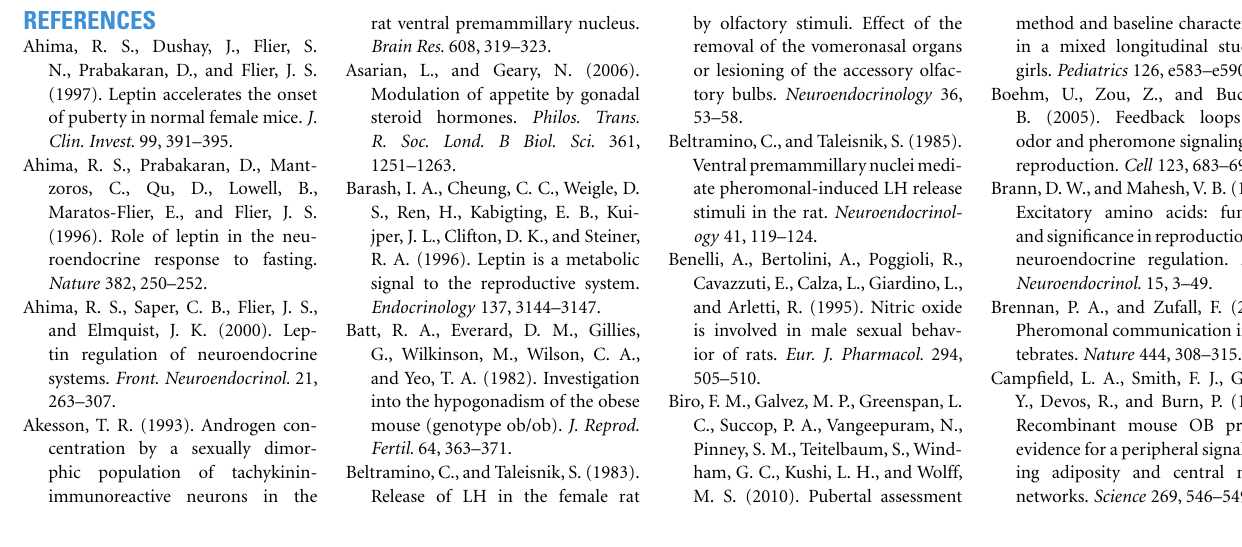
FIGURE 2 | Proposed role for the ventral premammillary nucleus (PMV) in the female reproductive physiology. The PMV integrates environmental cues (odors in rodents and daylight in seasonal breeders) and signals from the internal milieu related to the reproductive status (sex steroids) and energy store (leptin and insulin). PMV neurons express excitatory neurotransmitters